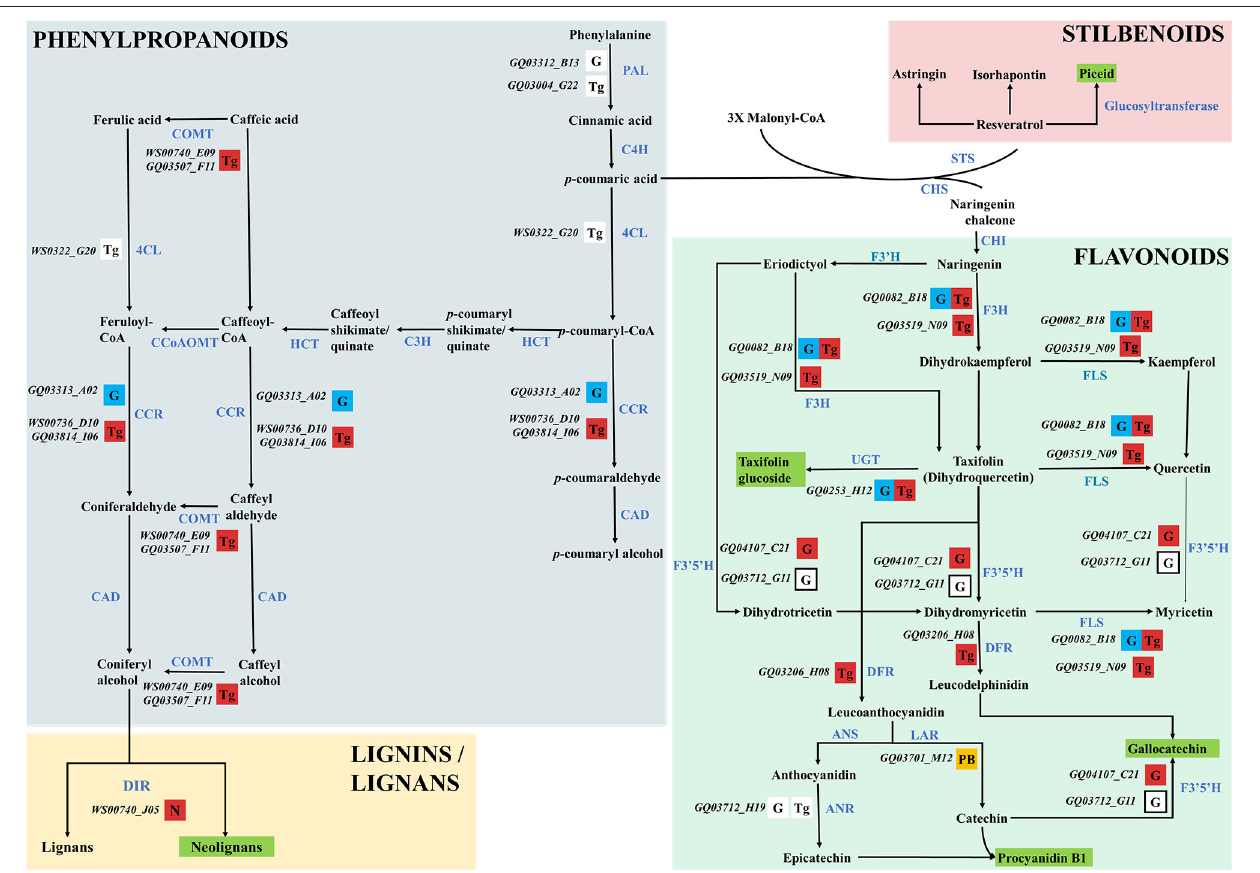
FIGURE 6 | Proposed phenolic compound biosynthesis pathway in spruce. The pathway presented here is adapted from Warren et al. (2015). Candidate gene IDs identified in this study were retrieved from the gene catalog GCAT3.3 ( Rigault et al., 2011) and are reported in black and italic. Genes identified in QTLs only are shown in orange boxes. Lower- or highly-expressed genes are indicated by blue and red boxes, respectively. Remaining DEGs (i.e., excluding high- and low expressed genes) are shown in white boxes. Genes within the taxifolin glucoside QTL and differentially expressed for gallocatechin are shown in white boxes with bold margins. The metabolite for which genes are differentially expressed is reported in each box according to the following nomenclature: G, gallocatechin; N, neolignan-2; P, piceid; PB, procyanidin B1; Tg, taxifolin glucoside. The five metabolites studied are underlined in green. Known key enzymes involved in the phenylpropanoid pathway are labeled in blue and bold capital letters. Abbreviations are as follow: 4CL, 4-coumarate-CoA ligase; ANR, anthocyanidin reductase; ANS, anthocyanidin synthase; C3H, p-coumaroyl shikimate/quinate 3 ′ -hydroxylase; C4H, cinnamate 4-hydroxylase; CAD, cinnamyl-alcohol dehydrogenase; CAD, cinamyl alcohol deshydrogenase; CCoAOMT, caffeoyl-CoA O-methyltransferase; CCR, cinnamoyl-CoA reductase; CHI, chalcone isomerase; CHS, naringenin-chalcone synthase; COMT, caffeic O-methyltransferase DFR, bifunctional dihydroflavonol 4-reductase/flavanone 4-reductase; DIR, dirigent protein; F3H, flavanone 3-hydroxylase; F3 ′ H,